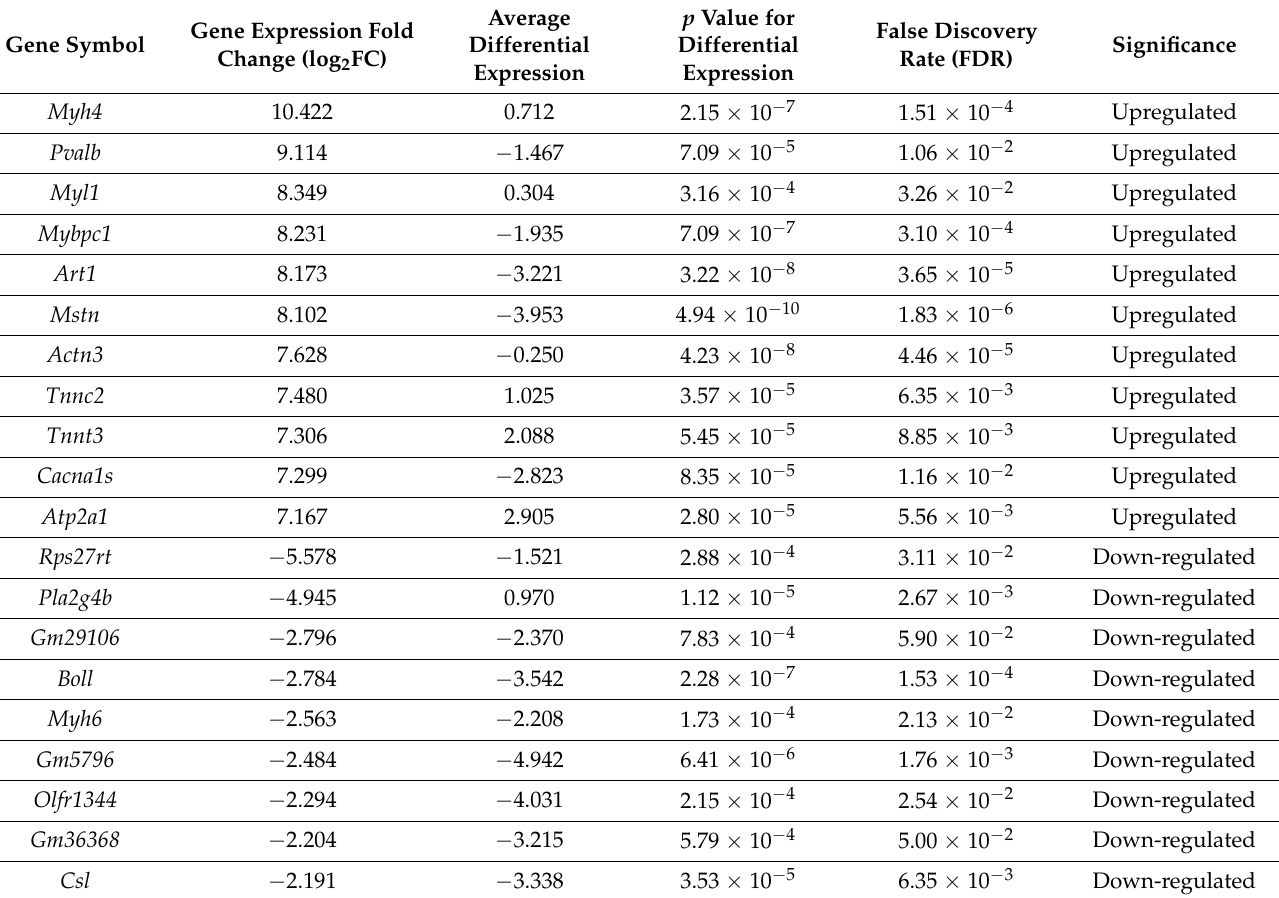
Table 3. Top 20 upregulated and down-regulated genes with the combination treatment, ranked by fold